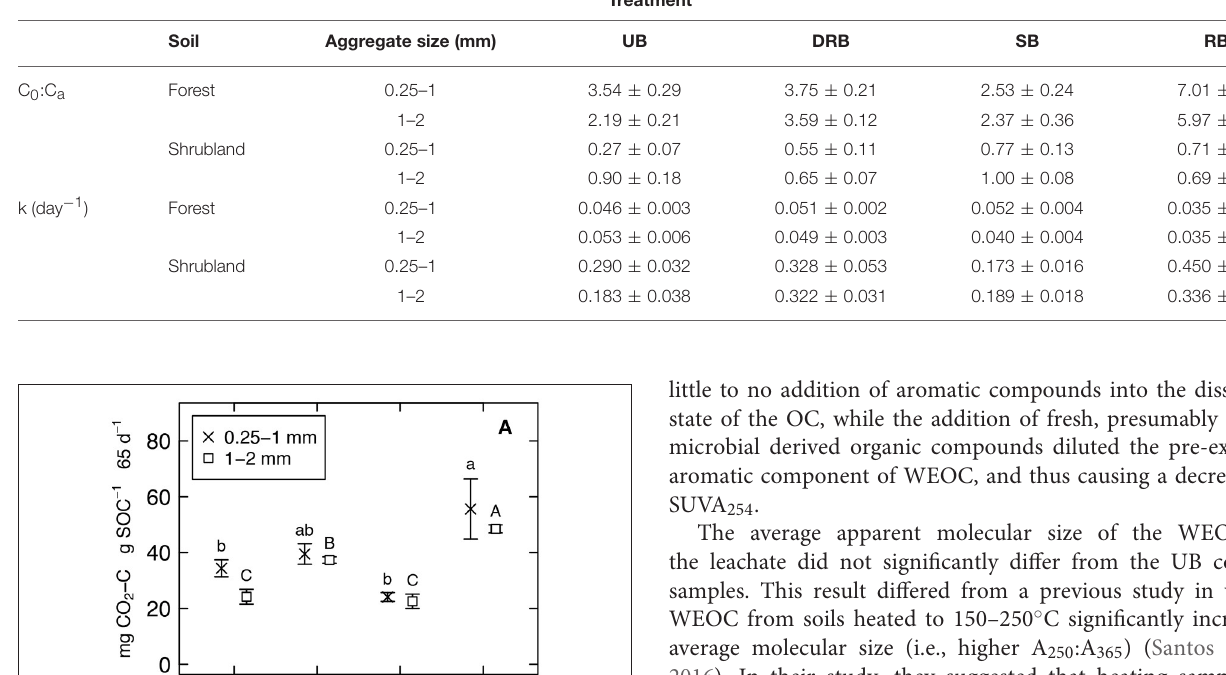
TABLE 2 | C 0 :C a [the ratio of the biologically available carbon pool to the total carbon pool (C a )] of unburned (UB), rapidly burned dried (DRB), rapidly burned (RB), and slowly burned (SB) soil aggregates from forest soil with aggregate sizes 0.25–1 and 1–2mm, and shrubland soil with aggregate sizes 0.25–1mm and 1–2mm. Treatment